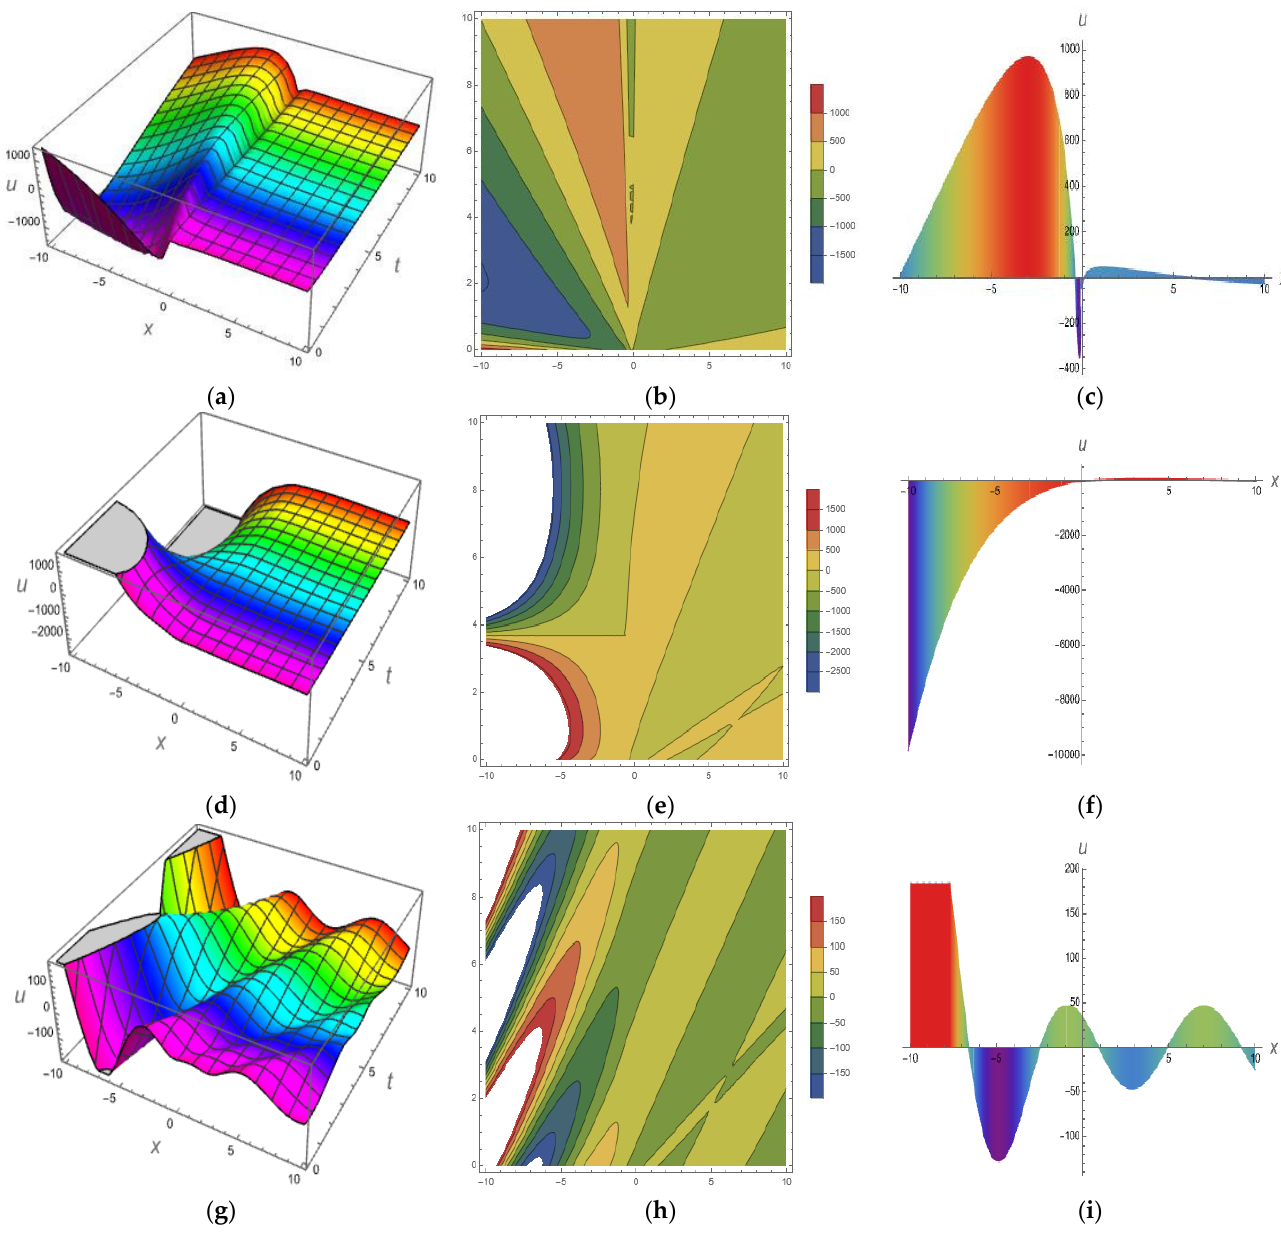
Figure 1. This figure presents the impact of fractional order on the solution Re ( U 1,1 ( x , t )) at a = 1,w = 0.9, P = 0.9, k = 0.9, c = 1, N = 0.7, a 0 = 2, a 2 = 11.56449544 I , ν = 0.1. ( a ) 3D visualization at. ( b ) Contour visualization at. ( c ) 2D visualization at α = 0.1. ( d ) 3D visualization at α = 0.5. ( e ) Contour visualization at α = 0.5. ( f ) 2D visualization at α = 0.8. ( g ) 3D visualization at α = 0.9. ( h ) Contour visualization at α = 0.9. ( i ) 2D Visualization at α = 0.9.